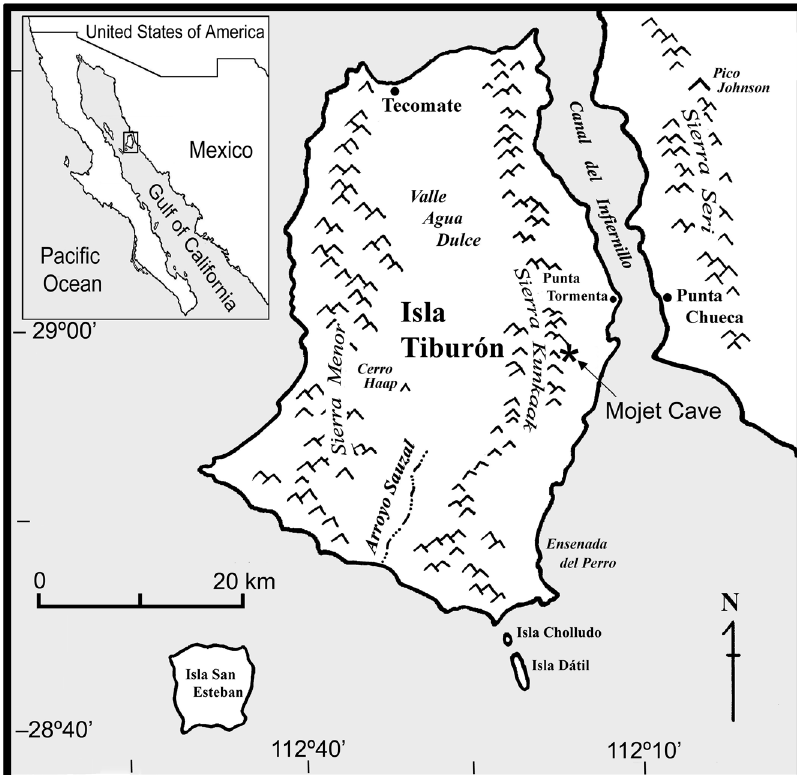
Figure 1. Tiburo´n Island in Gulf of California.